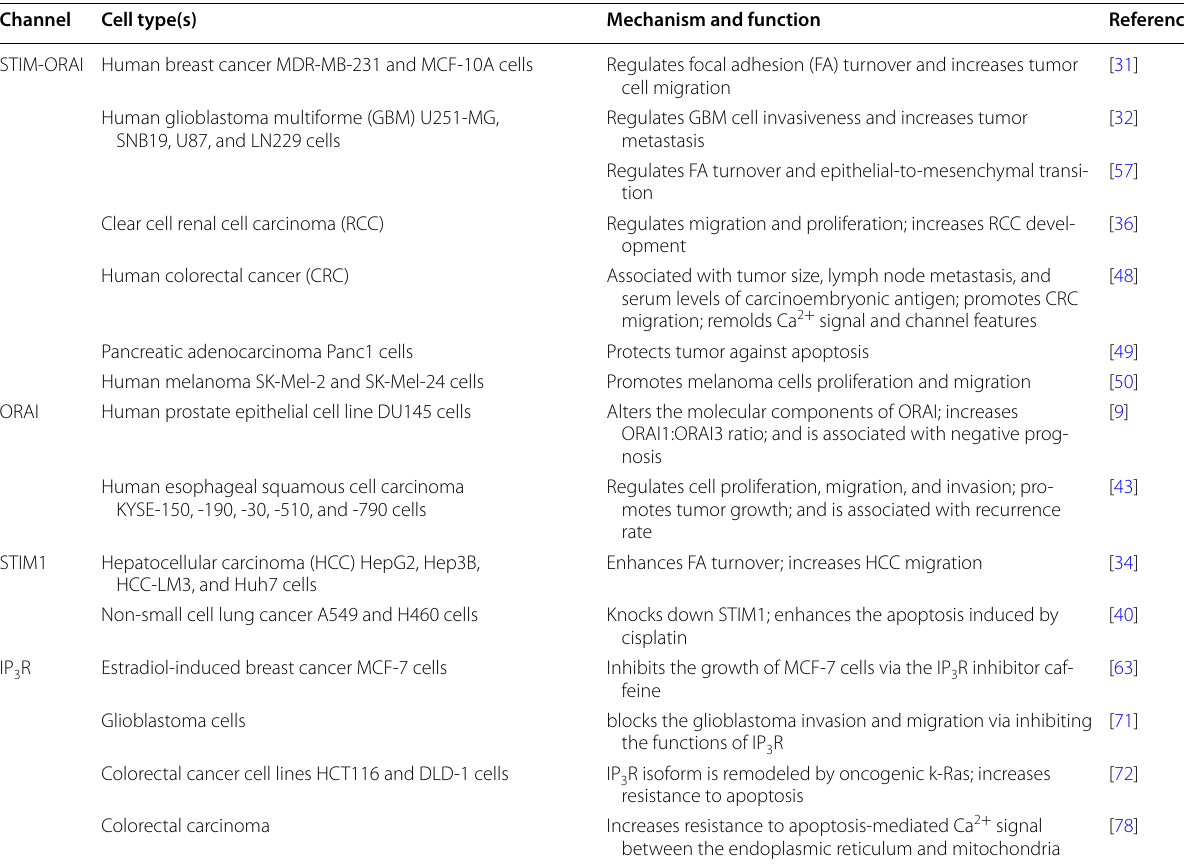
Rs) in tumor invasion and metastasis 3